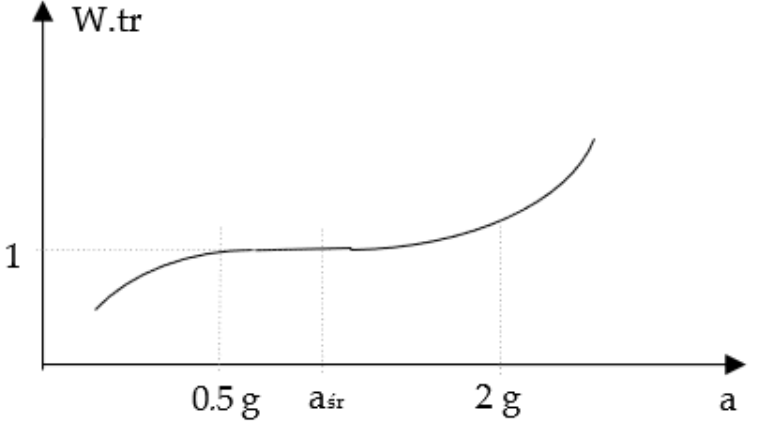
Figure 4. Dependence of the coefficient of difficulty on overload (acceleration a expressed in multiples of g).